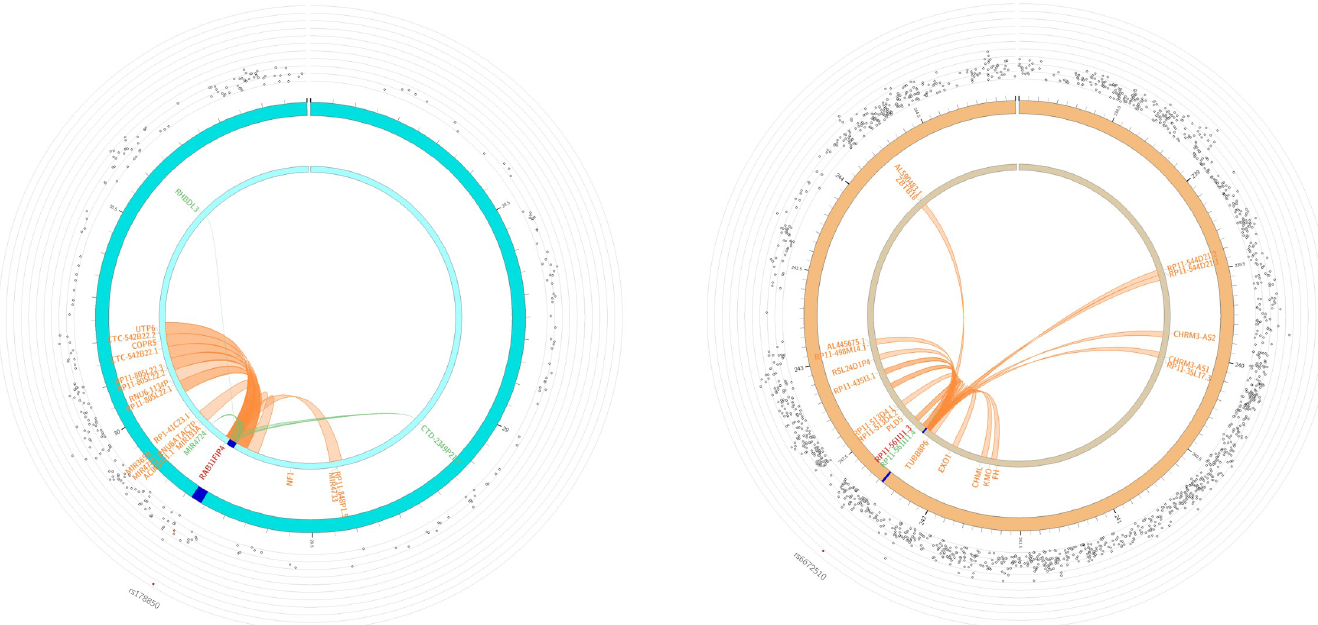
Fig 6. FUMA circular plots of chromatin interactions and eQTLs of lead SNPs. a ) The plot of chromosome 17, showing the lead SNP, rs178850, of RAB11FIP4 gene and its interactors. b ) The plot of chromosome 1, illustrating the second lead SNP, rs6672510, of PLD5 gene and its interactors. The outer ring (grey dots) shows the Manhattan plot of all the SNPs in the chromosome, with p < 0.05, and not in LD with the lead SNP. The lead SNPs are indicated with a red dot. Both inner rings indicate the chromosome, with the risk loci highlighted in blue. The links and labels indicate chromatin interactions (orange) and eQTLs (green). When the SNP is mapped by both chromatin interactions and eQTLs, as in the case of rs178850, it is highlighted as red.